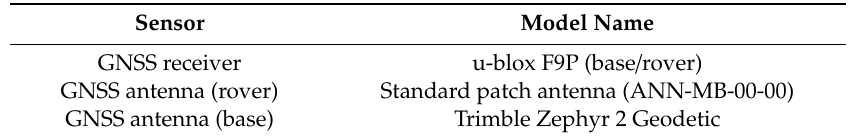
Table 3. Configurations of sensors used in the test.